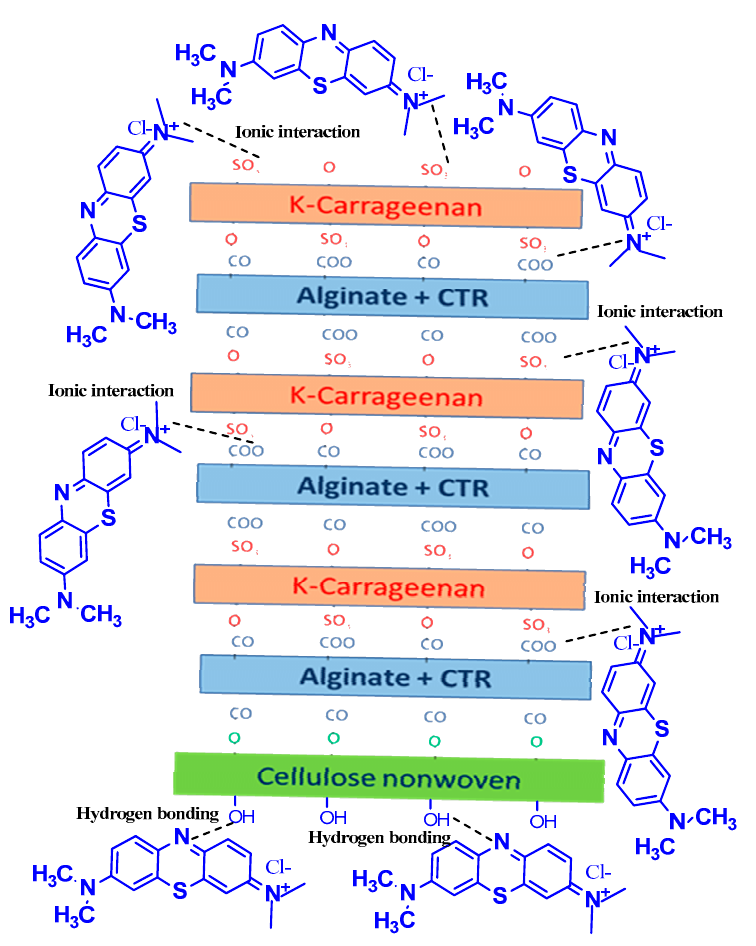
Scheme 1. A schematic representation of hydrogen bonding and ionic interaction between methylene blue molecule and the surface of PEM crosslinked to non-woven cellulosic textile material. The adsorbed dye amount was found to greatly increase with the increase of initial methylene blue concentration. At equilibrium, it reached 171.4 mg/g for the untreated samples and 590.5 mg/g for the grafted samples (Figure 6c). This adsorbed amount de-